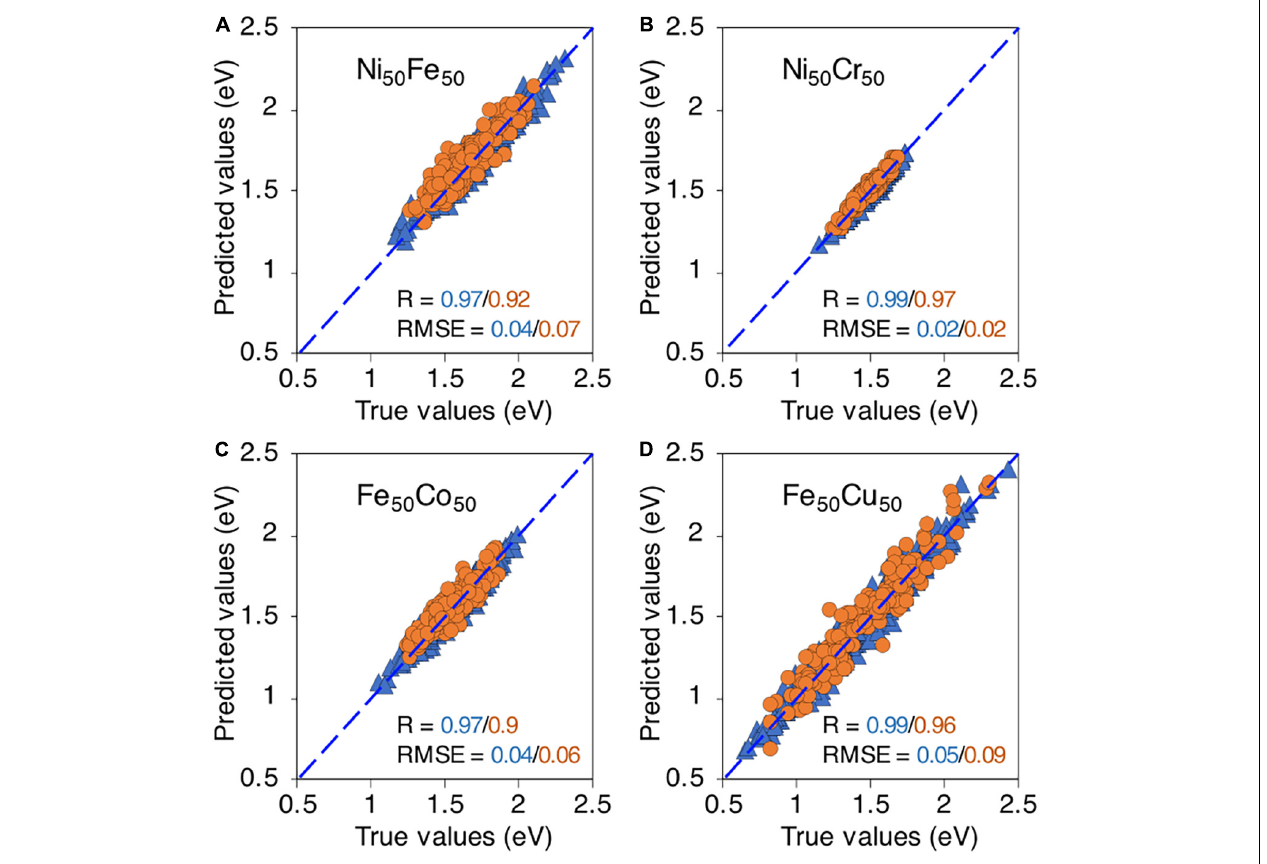
FIGURE 10 | True vs machine learning predicted vacancy formation energies in, (A) Ni 50 Fe 50 , (B) Ni 50 Cr 50 , and (C) Fe 50 Co 50 , and (D) Fe 50 Cu 50 . The blue triangles and orange circles are training and testing data points